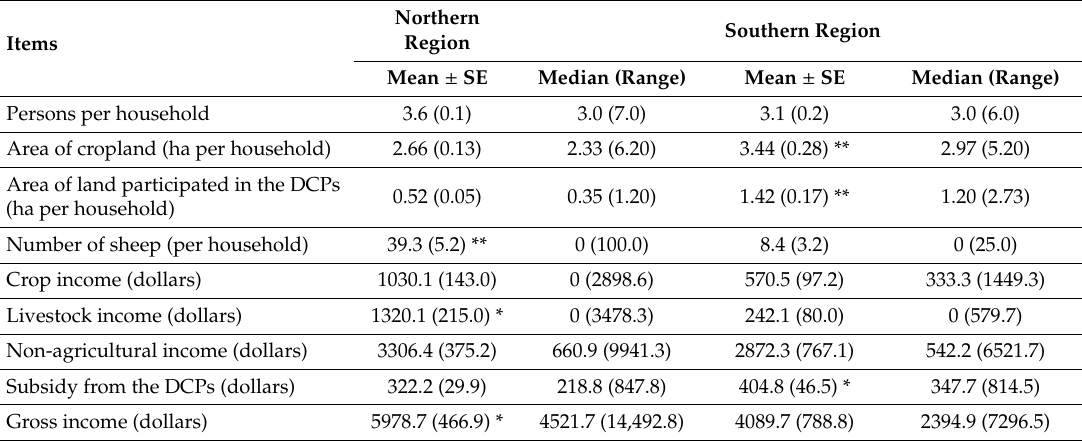
Table 1. Basic family information of farmers.